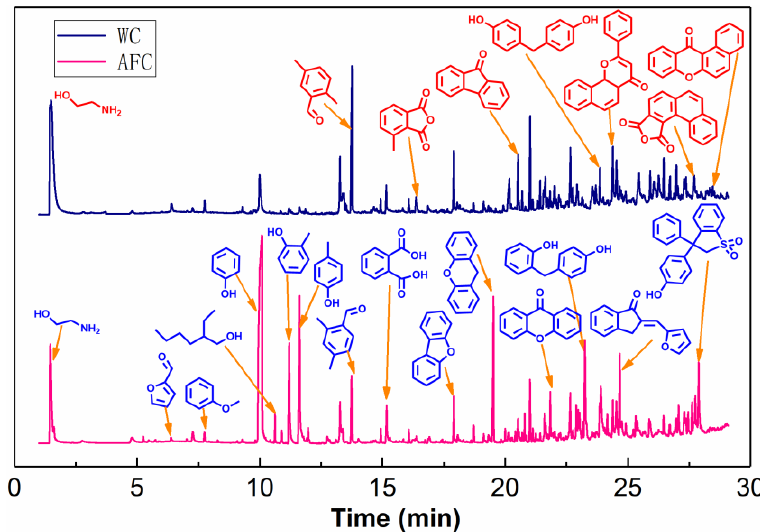
Figure 10. Thermal cracking gas chromatography-mass spectrometry (PY-GCMS) of AFC and WC samples.